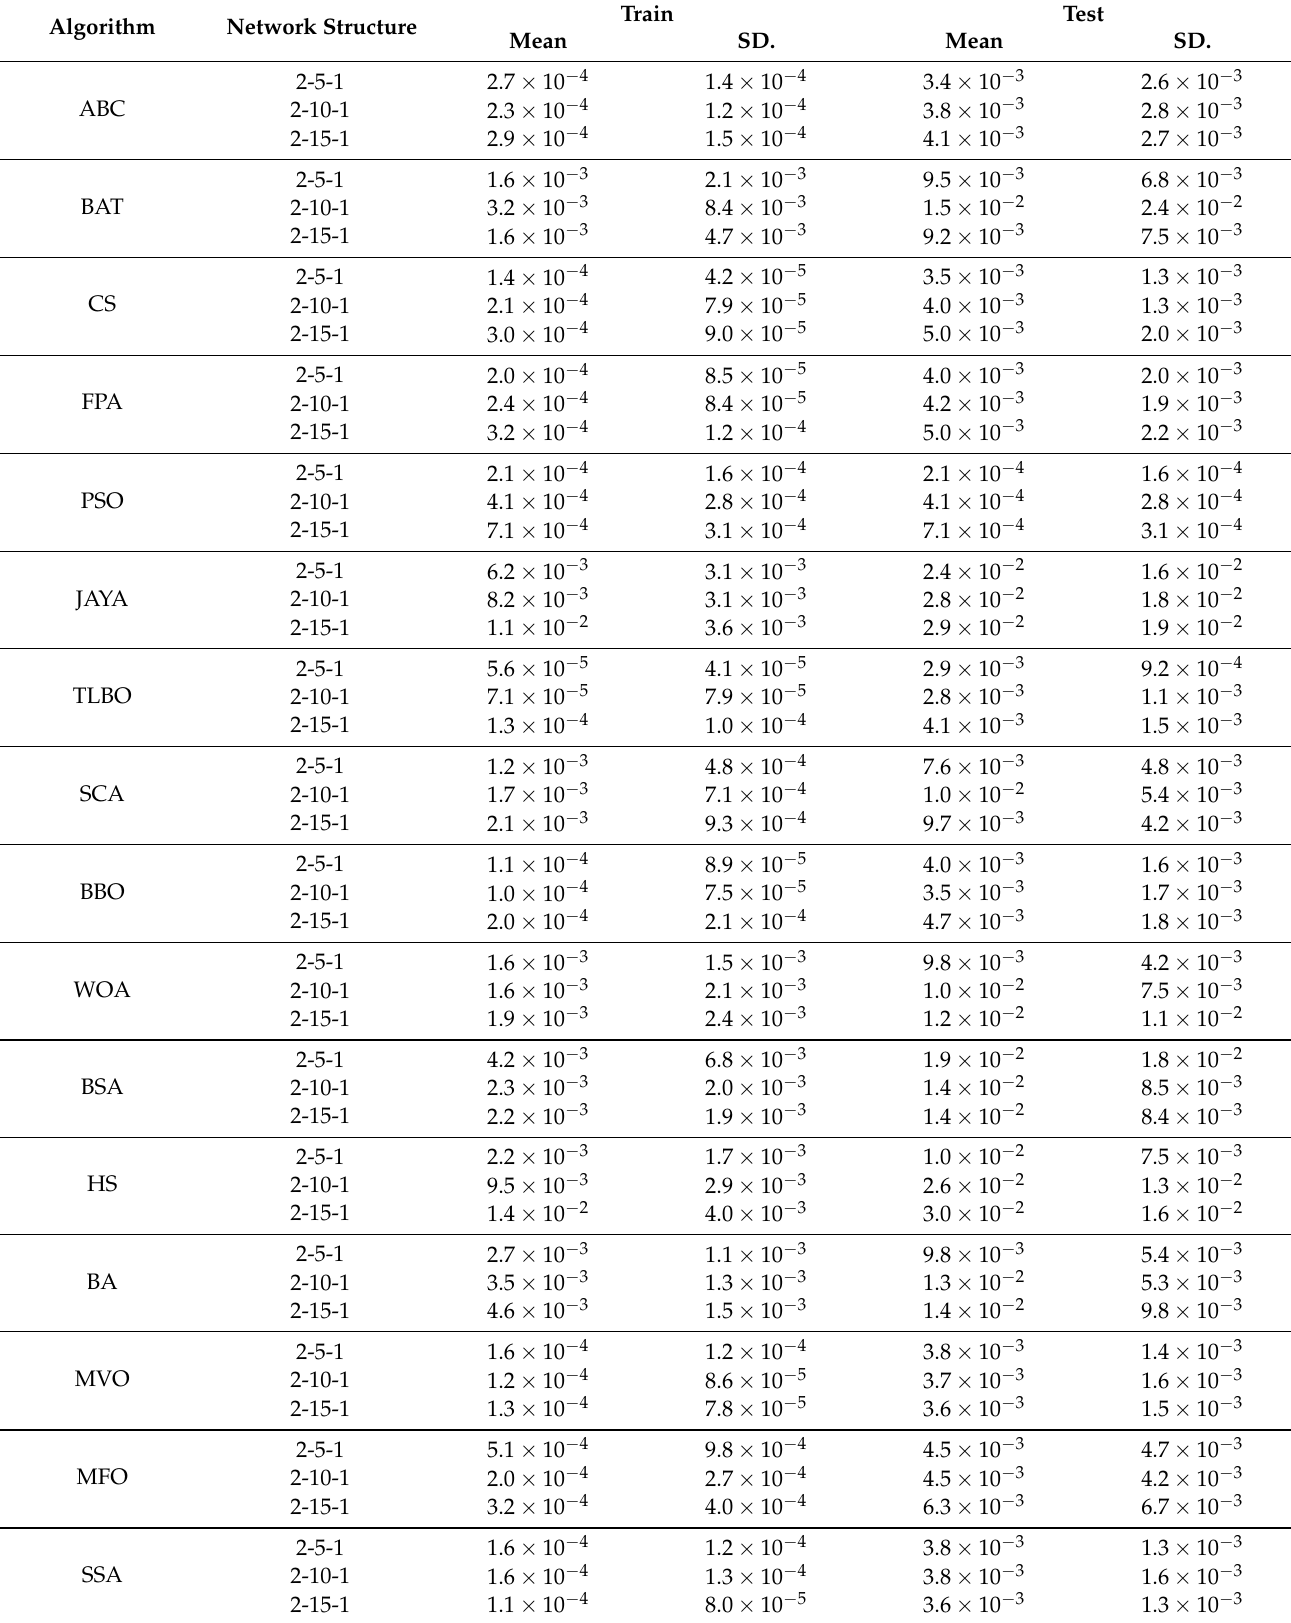
Table 4. The results obtained by using the metaheuristic algorithms for S 3